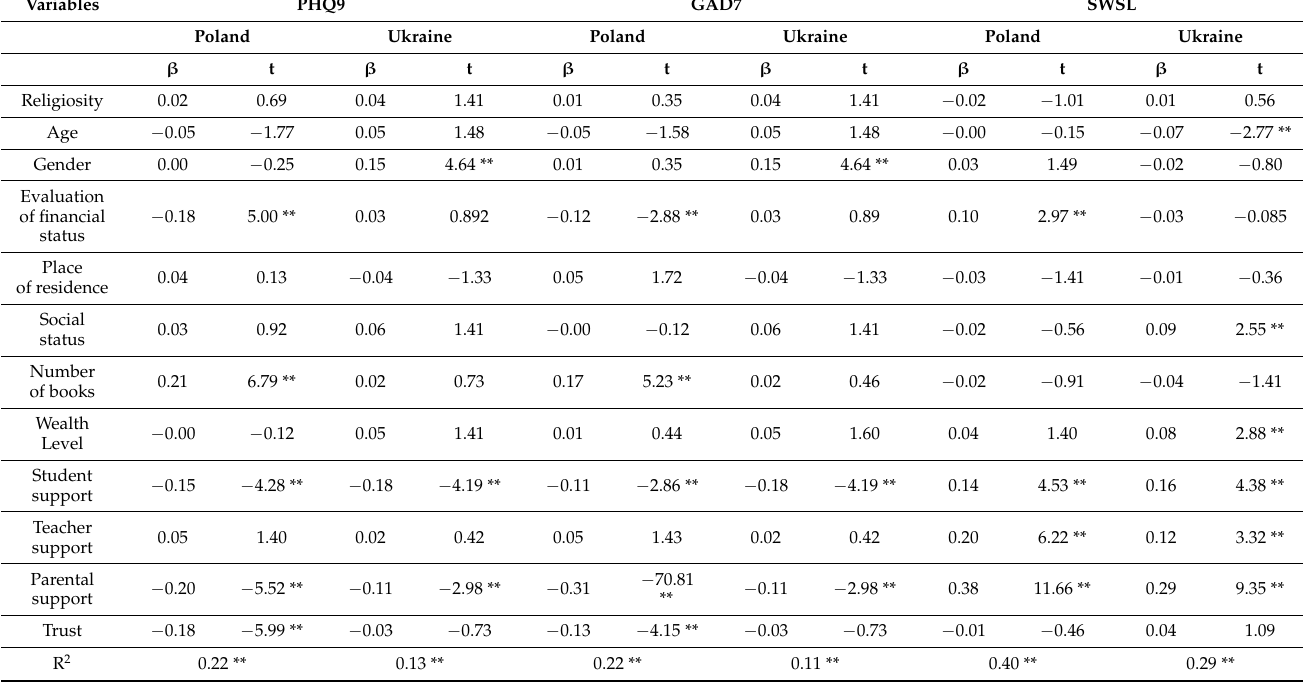
Table 5. Results of regression